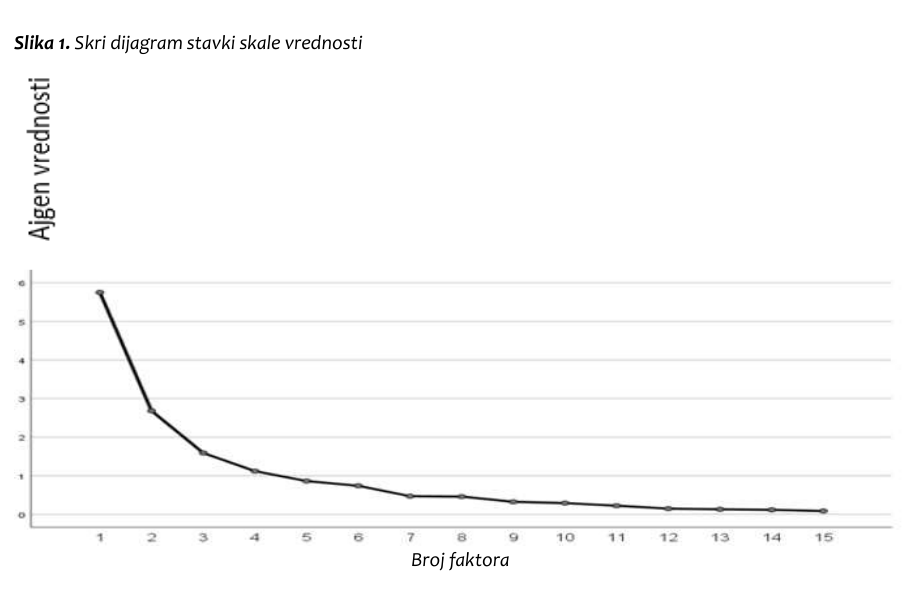
Hrišćanske Svetovne vrednosti vrednosti 0.85 0.83 0.76